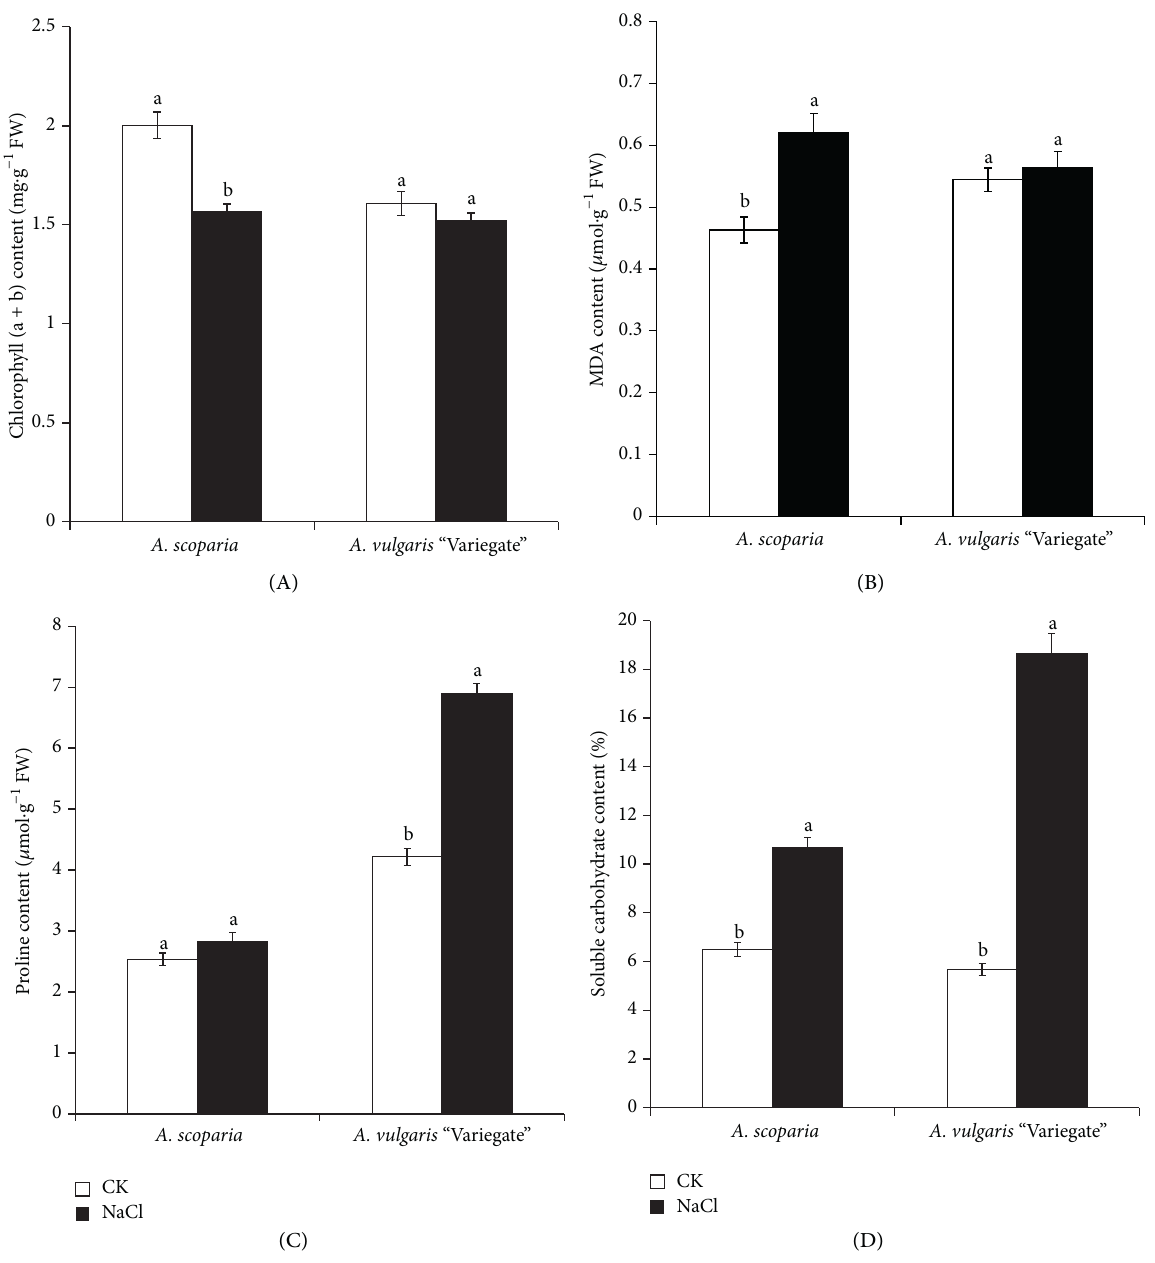
Figure 2: Effect of NaCl on contents of chlorophyll (a + b), MDA, proline, and soluble carbohydrate content in leaves. CK: 0 mmol ⋅ L −1 NaCl treatment; NaCl: 200 mmol ⋅ L −1 NaCl treatment. The different letters represent significant difference at 𝑃 < 0.05 between CK and NaCl by Duncan’s New Multiple Range Test. Error bars represent standard